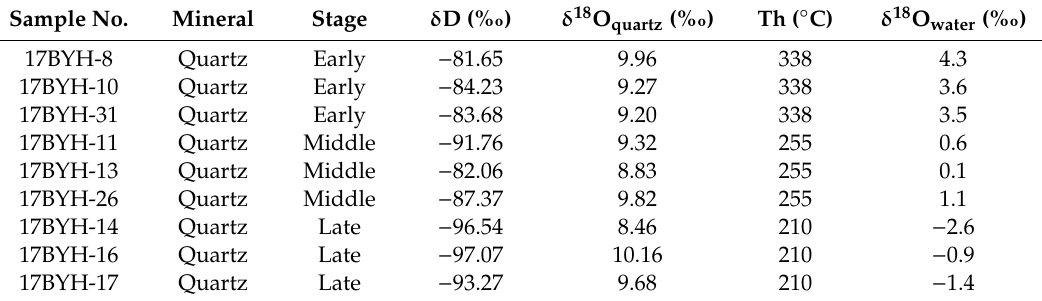
Table 2. Hydrogen and oxygen isotopic compositions of quartz from the Baiyinhan tungsten deposit. Sample